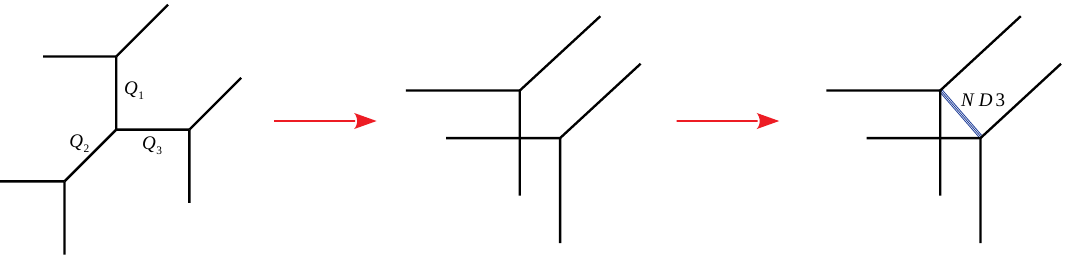
Figure 2 . Schematic representation of the geometric transition from the 5 d T 2 theory to the 3 d U( N ) theory. At the (cid:12)rst step we un-resolve the singularity of the quantized P 1 . At the second step, we move apart the two sets of intersecting (cid:12)ve-branes, between which can then stretch N D3 branes. On this D3 branes lives the U( N )